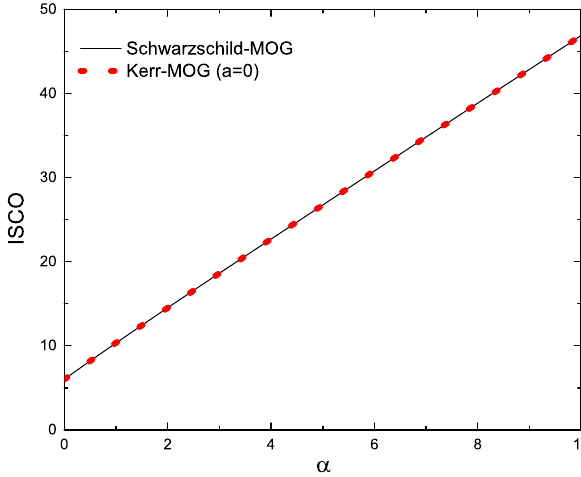
Fig. 8 Radius of stable circular orbit and energy E of a function of r . For α = 9, a = 0 . 95, there is a minimum point at ISCO r = 38 . 672 and energy E is a function of r . For α = 0 . 5, a = 0 . 95, there is a minimum point of the effective potential equal to ISCO at r = 4 . 328